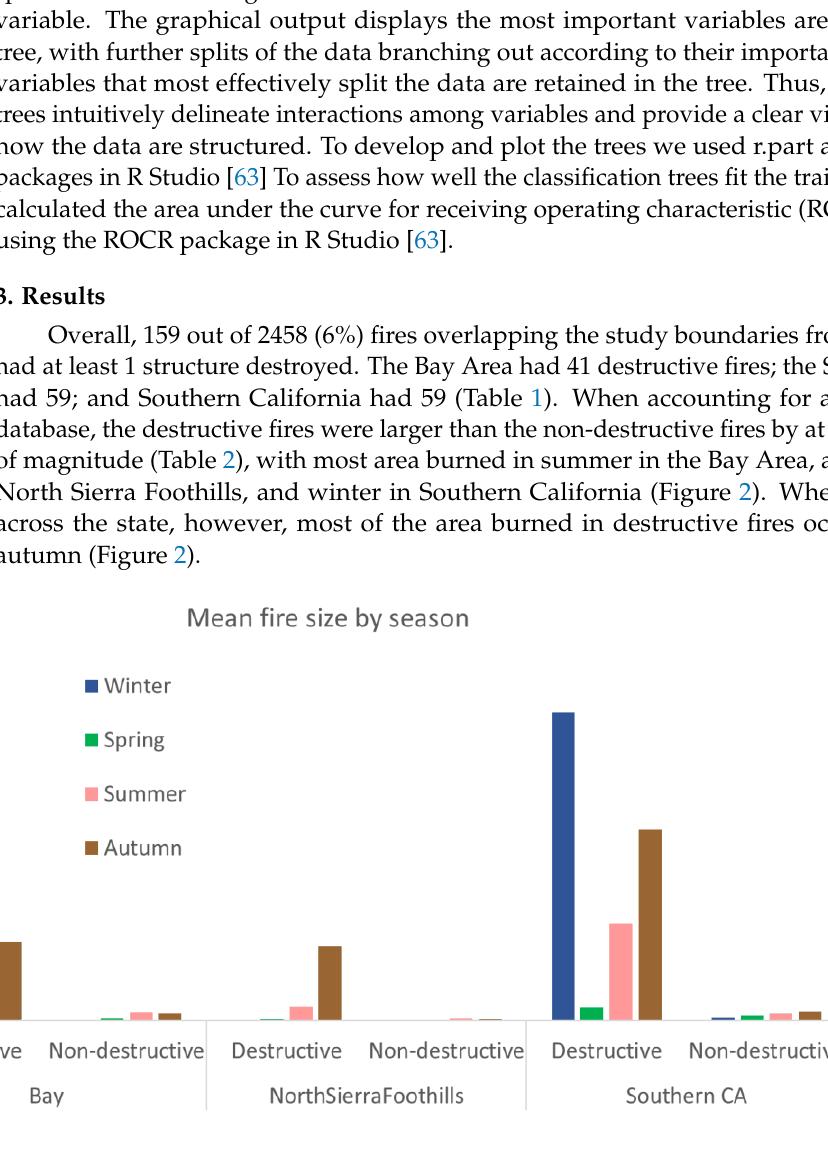
Figure 2. Mean fire size by season for destructive and non-destructive wildfires in three California regions and statewide from 2000–2018. Table 2. Mean and median fire size (ha) for all (n = 2458) destructive and non-destructive fires from 2000–2018 in three California